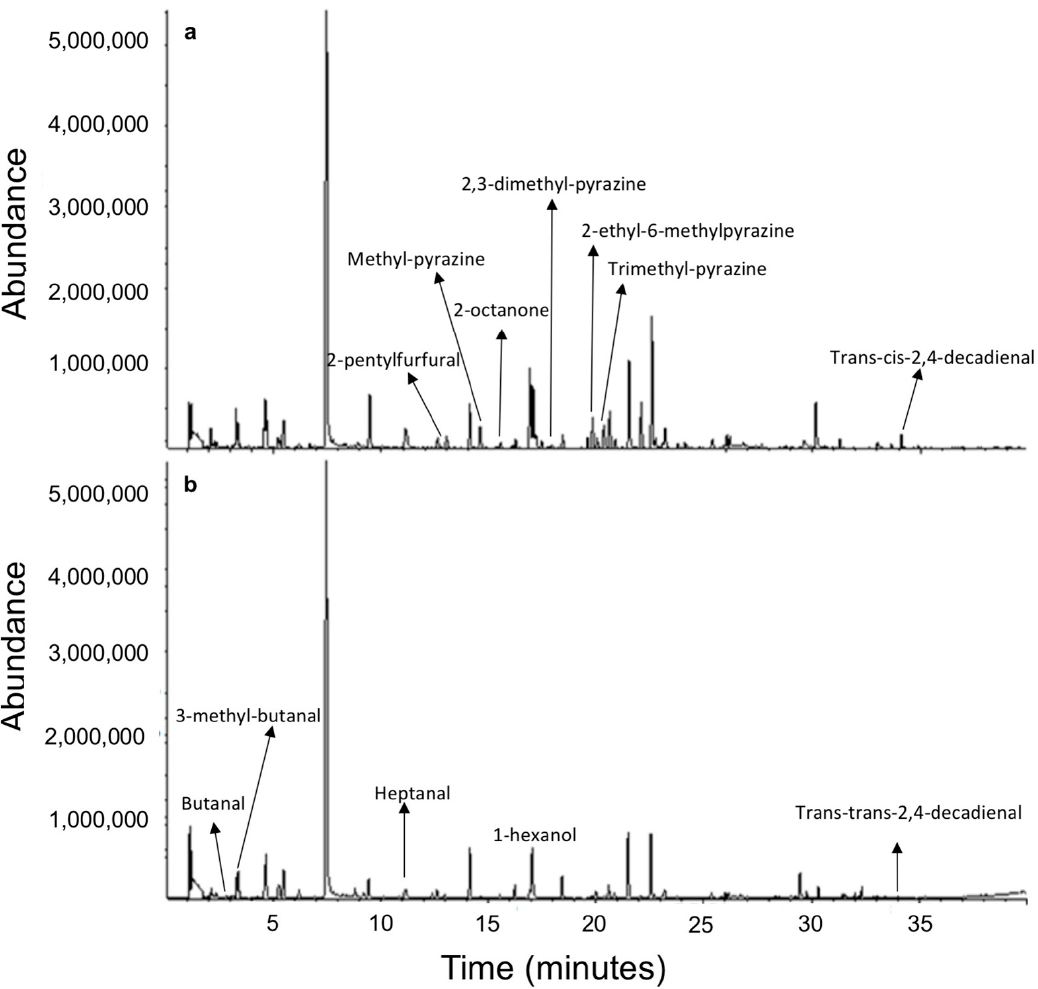
Figure 3. Full-scan chromatograms obtained for roasted ( a ) and fried ( b ) sunflower seed samples at day 0 of oxidative treatment.